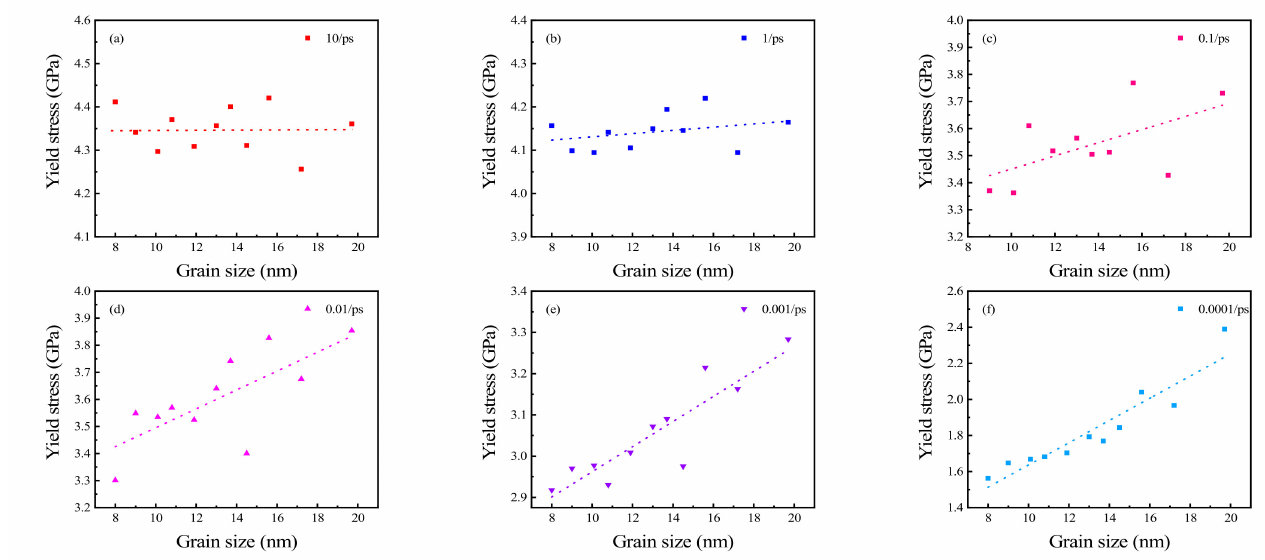
Figure 7. Yield stress of polycrystalline Cu 6 Sn 5 at strain rates of ( a ) 10 ps − 1 , ( b ) 1 ps − 1 , ( c ) 0.1 ps − 1 , ( d ) 0.01 ps − 1 , ( e ) 0.001 ps − 1 , and ( f ) 0.0001 ps − 1